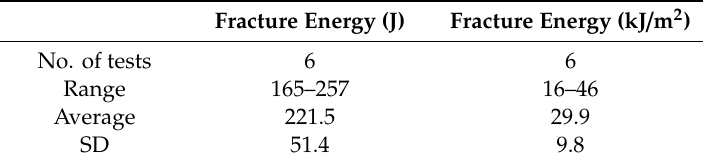
Table 14. Fracture energy average value and standard deviation.